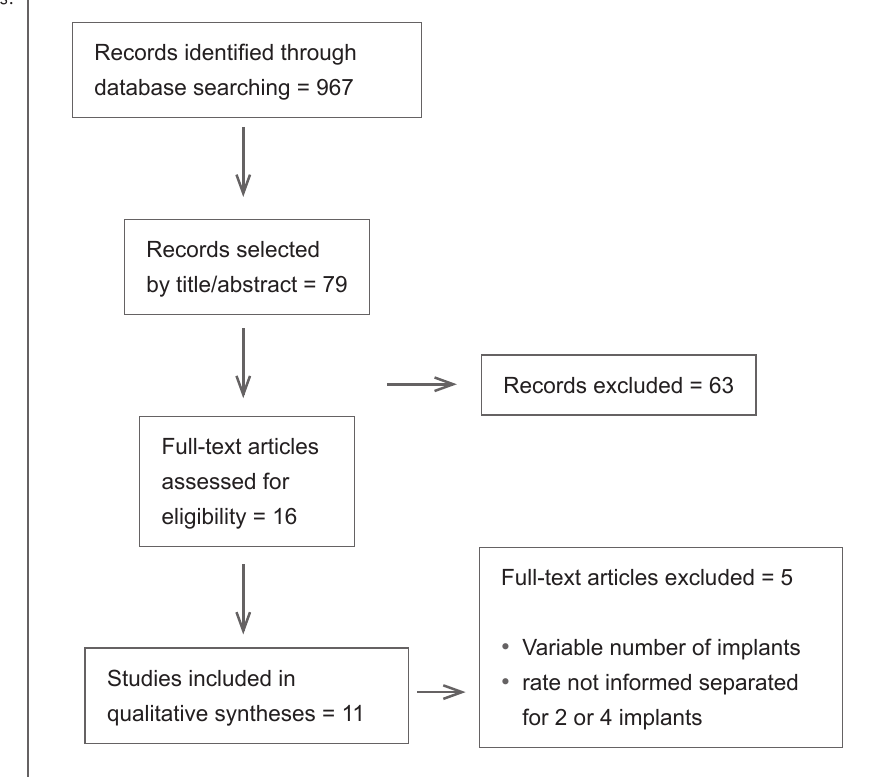
Figure 1 - Search